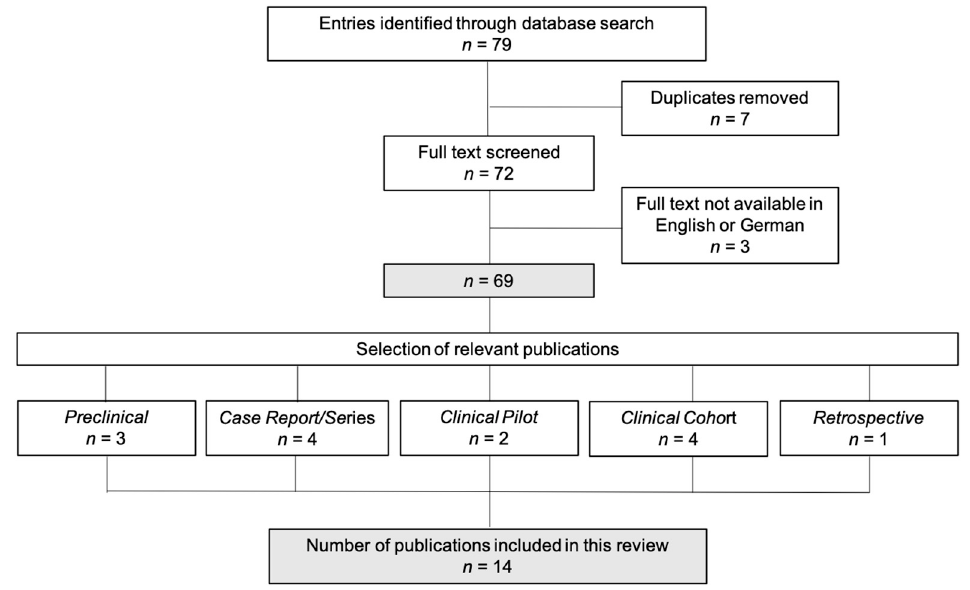
Figure 1. Study inclusion. In total, 79 publications evaluating the use of acellular fish skin grafts in burn injuries were identified. After elimination of duplicates ( n = 7), full-text evaluation of the remaining publications was performed ( n = 72). Only articles published in English or German language were included (exclusion of n = 3). 14 publications were determined eligible and included in the present review. Study types were defined as follows: preclinical study ( n = 3), case report/series ( n = 4), clinical pilot study ( n = 2), clinical cohort study ( n = 4), retrospective data analysis ( n = 1).